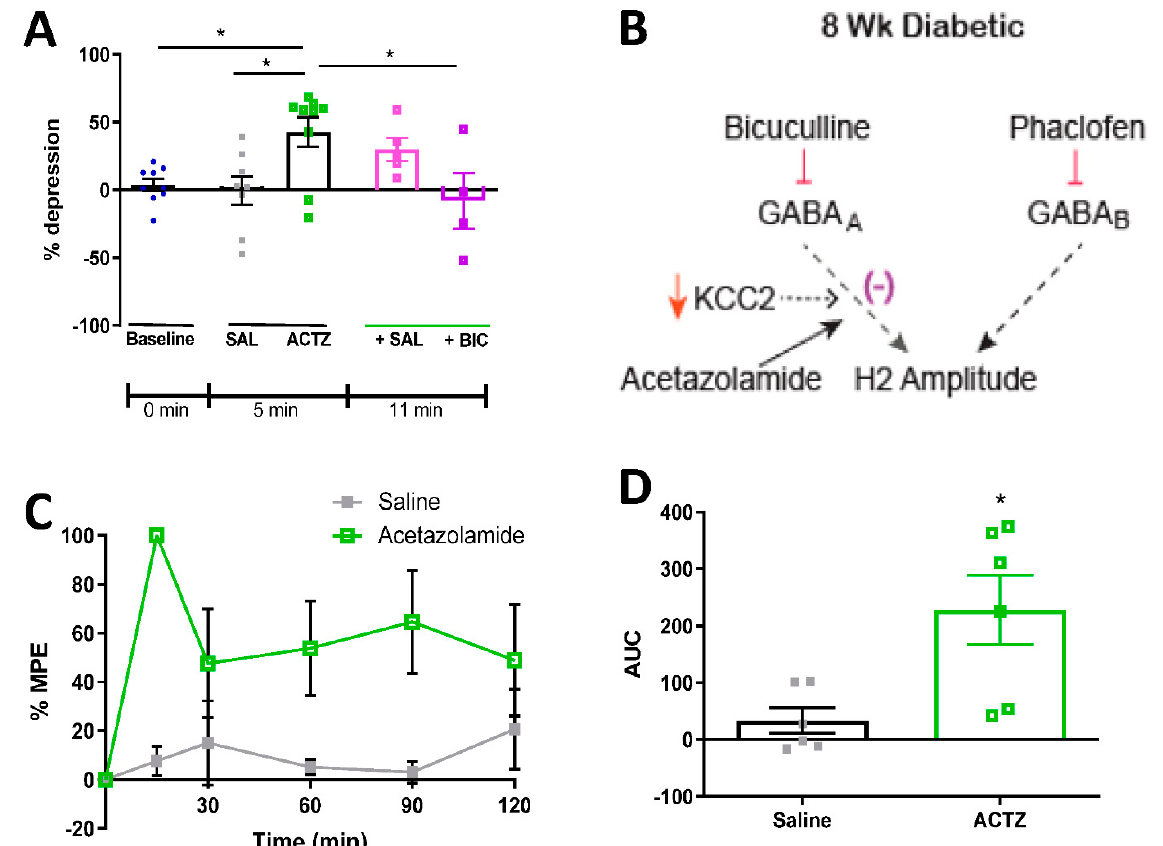
Figure 5. Effect of acetazolamide on RDD and tactile allodynia in diabetic rats. ( A ) % depression of the H-reflex in response to 1 Hz stimulation frequency in 8-week diabetic rats at baseline, 5 min after the administration of saline (SAL) or acetazolamide (ACTZ; 22.5 µg IT). One minute later (6 min after acetazolamide), saline (+Sal) or bicuculline (0.6 µg; + BIC) was administered IT and RDD was assessed 5 min later. * p < 0.05 compared to ACTZ by one-way ANOVA followed by Tukey’s post-hoc test. n = 4–9 per group. ( B ) Schematic summarizing of how acetazolamide restores RDD through enhancing GABA A receptor-mediated inhibitory function. ( C ) Tactile response threshold in 8-week diabetic rats assessed at regular intervals after IT administration of acetazolamide (22.5 µg) expressed as % MPE relative to baseline values. ( D ) AUC of tactile withdrawal thresholds in 8-week diabetic rats after administration of saline or acetazolamide (22.5 µ g). Data are presented as mean ± SEM. * p < 0.05 compared to saline by unpaired two-tailed t-test. N = 5–7 per